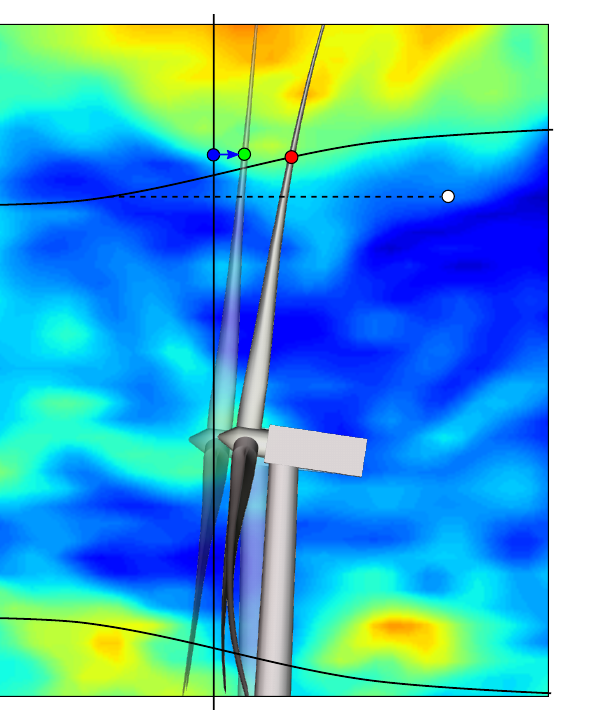
Figure 8. The estimated free flow at the sensor position (red dot) is compared to the free flow at the assumed position (green dot). In the EllipSys3D–Flex5 simulations, the nearest available free-flow velocity is at the rotor-centre plane (blue dot). The sensor is, how- ever, exposed to “delayed” turbulence structures that originate from a smaller radial position (white